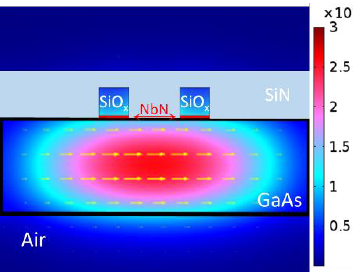
Figure 3. Simulated amplitude (V/m) and direction of the electric field for the fundamental mode of a suspended nanobeam (SNB) with a top niobium nitride (NbN) wire.